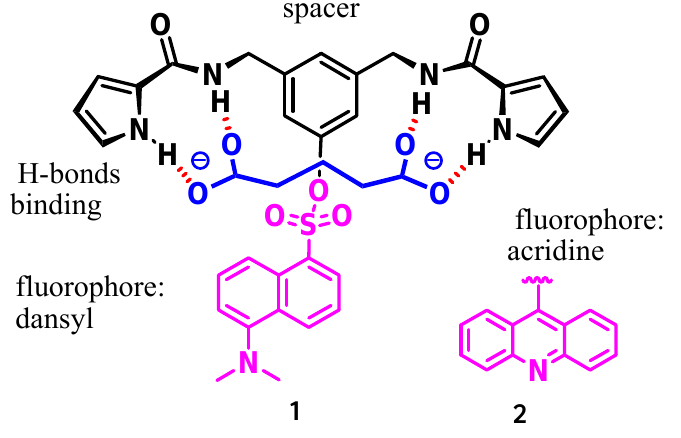
Figure 1. Proposed structure for the complexes of 1 and 2 with